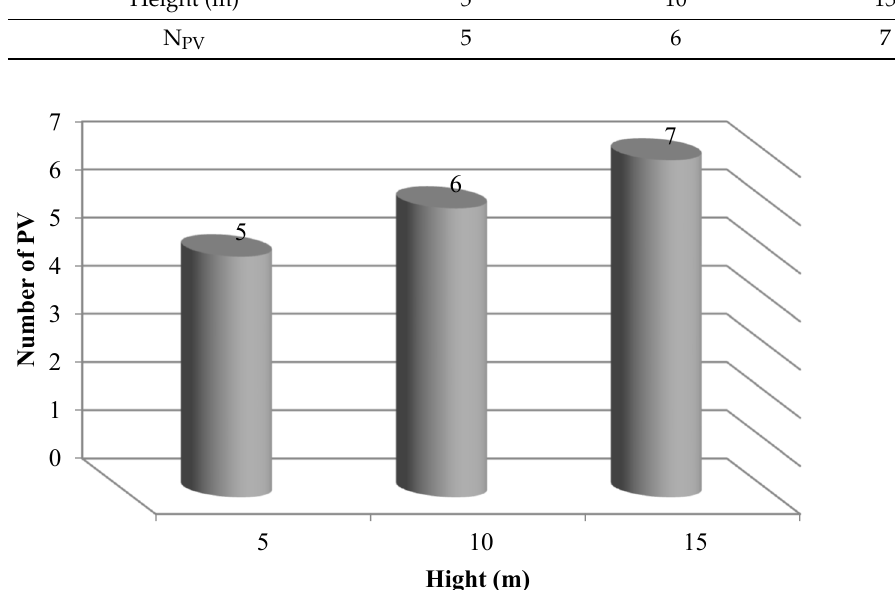
Figure 10. Curve of changes in the number of PV arrays relative to water extraction height.